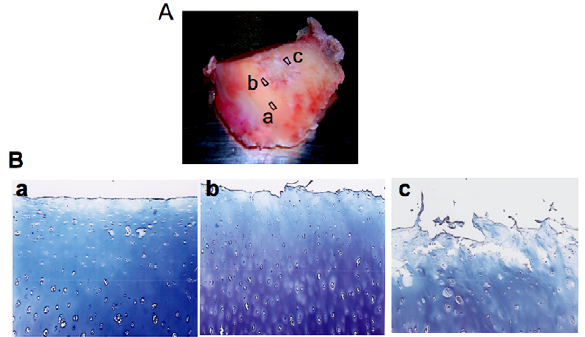
Figure 1. Representative sample of femoral condyle from human OA knee and toluidine blue stained sections. (A) Femoral condyle from human OA knee joint indicating three sites biopsied for further biochemical and molecular analysis; (a) cartilage sample taken from macroscopically unaffected area and distant from the lesion was termed ‘‘normal’’ (b) cartilage sample isolated from areas immediately close to lesion was termed ‘‘Next to lesion’’; (c) cartilage specimen excised from lesion was termed ‘‘late-stage OA’’; Cartilage samples were isolated using a 6 mm-biopsy punch. (B) Representative photomicro- graphs of cartilage sections showing areas from where samples were recovered for toluidine blue staining; (a) cartilage section from a normal area showing a relatively smooth articular surface; (b) section from areas close to lesion showing dense staining for PGs in mid zone of the cartilage where chondrocyte proliferation and activation occurs; (c) cartilage section from lesions showing degraded articular surface, loss of PG staining and chondrocyte cloning (original magnification 6